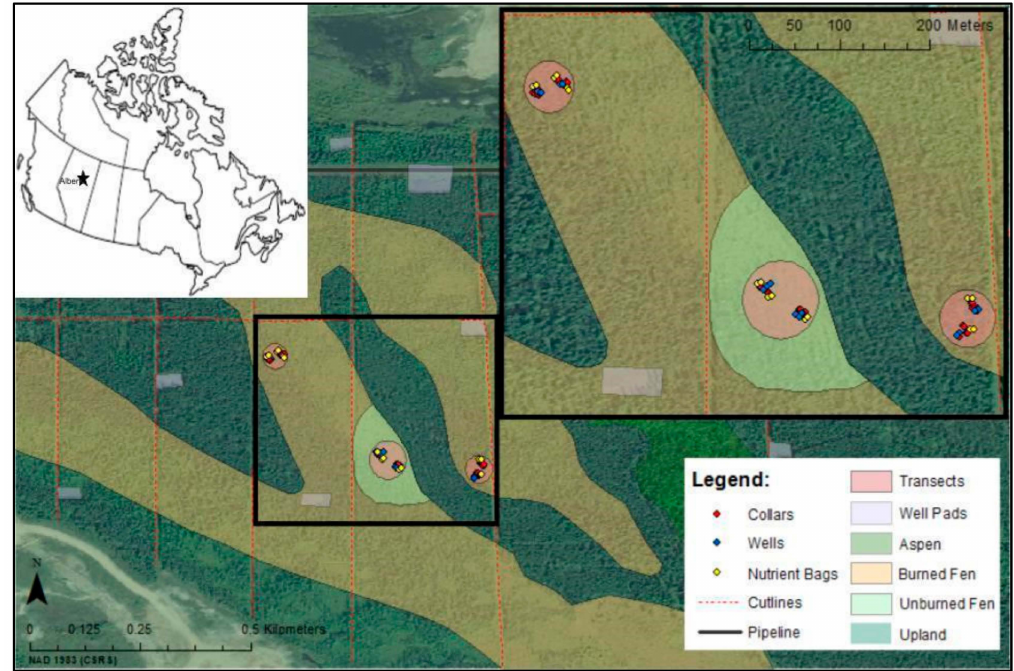
Figure 1. Map of the Poplar study area denoting the Burned and Unburned areas after the wildfire, and the three study transects: two burned and one unburned area of the